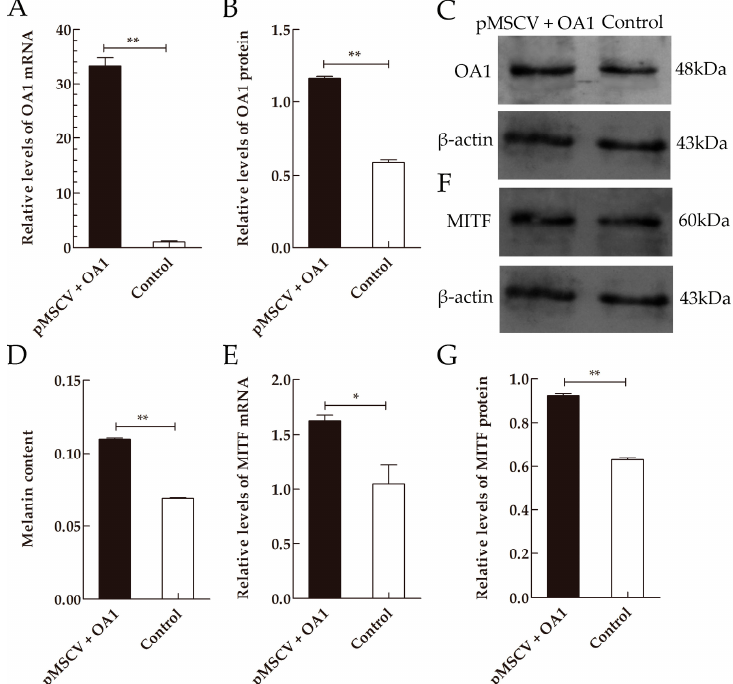
Figure 3. The overexpression of OA1 affects the melanin content in an MITF-dependent fashion. Mice OA1 was PCR amplified and then subcloned into the pMSCV PIG vector with Xho I and EcoR I restriction sites. The pMSCV- OA1 -GFP plasmid or empty vector was transfected into the mouse melanocytes. The cells were harvested to extract total RNA and total protein. The expression levels of OA1 were qualitatively and quantitatively analyzed by qRT-PCR and Western blot. ( A ) Melanin contents in melanocytes transfected with OA1 , as well as the control; ( B – D ) transfection efficiency of OA1 in mouse melanocytes; ( E – G ) OA1 overexpression influences microphthalmia-associated transcription factor ( MITF ) mRNA and protein levels in mouse melanocytes. Data are shown as the mean ± standard errors ( n = 3 each), * p < 0.05, ** p < 0.01.